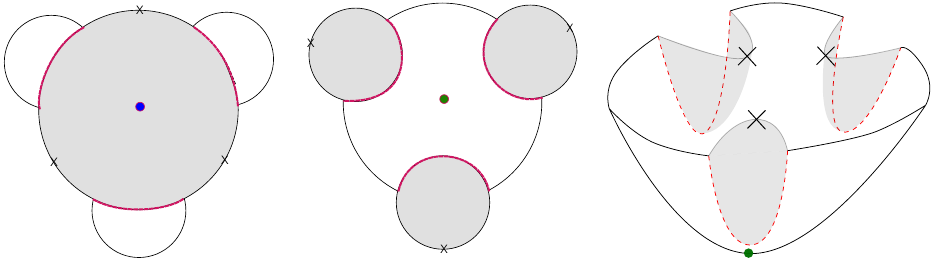
Figure 8 . ( Left and Middle ) Two geometries which contribute to the calculation of the third R(cid:19)enyi entropy Tr (cid:26) 3 of the radiation in our setup. The white regions are the original black hole side R of the spacetime, while the shaded regions are the inception side. The EOW branes are marked out by red dashed lines. Note that these are three-dimensional Euclidean spacetime geometries, we have simply suppressed the spatial circle, and deformed them into a two dimensional plane. The left geometry smoothly caps o(cid:11) at the RT surface (blue dot) in the inception black hole and dominates in the Hawking phase, while the middle geometry caps o(cid:11) smoothly at the RT surface (green dot) in the original black hole and dominates in the island phase. The crosses label points at which two copies of the asymptotic boundary are glued together in the replicated manifold. ( Right ) A visualization of the two-dimensional surface in the middle panel, embedded in three dimensions instead of two, in the style of (cid:12)gure